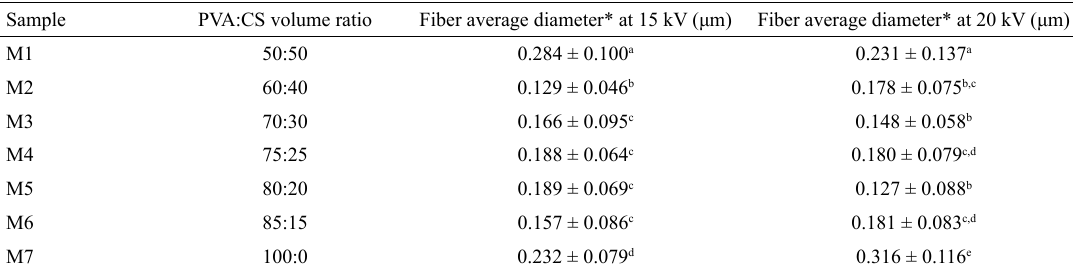
Figure 2. Diameter distributions for PVA/CS nanofibers electrospun at 15 and 20 kV, respectively, from mixed solutions at 50:50 (mixture M1; a, a1), 60:40 (mixture M2; b, b1), 70:30 (mixture M3; c, c1), 75:25 (mixture M4; d, d1), 80:20 (mixture e, e1), 85:15 (mixture M6; f, f1), 100:0 (mixture M7; g, g1) compositions. Table 1. Fiber average diameters for PVA/CS